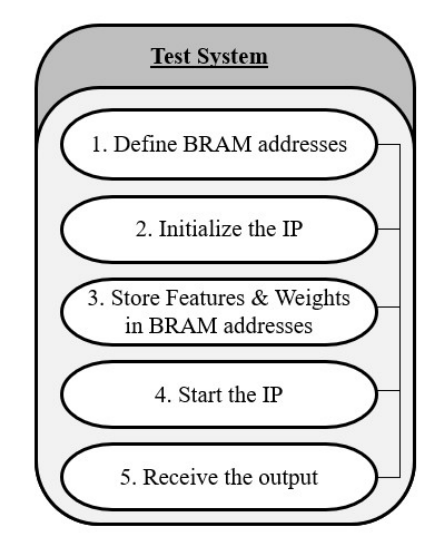
Figure 7. SDK test for the BRAM architecture.